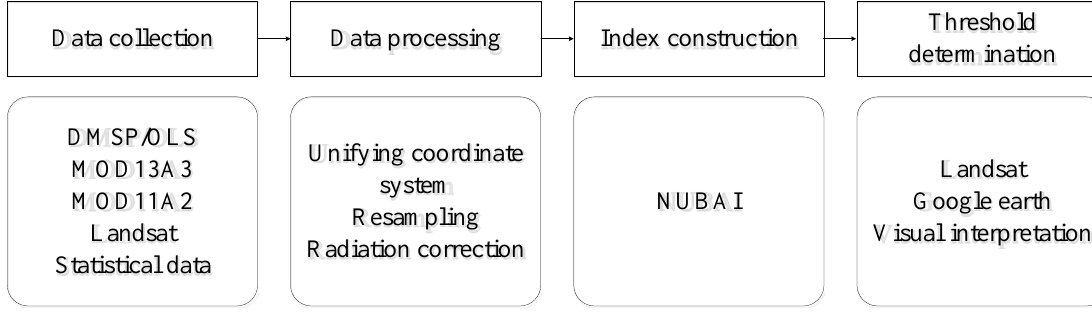
Figure 2. Process of the urban built-up extraction.